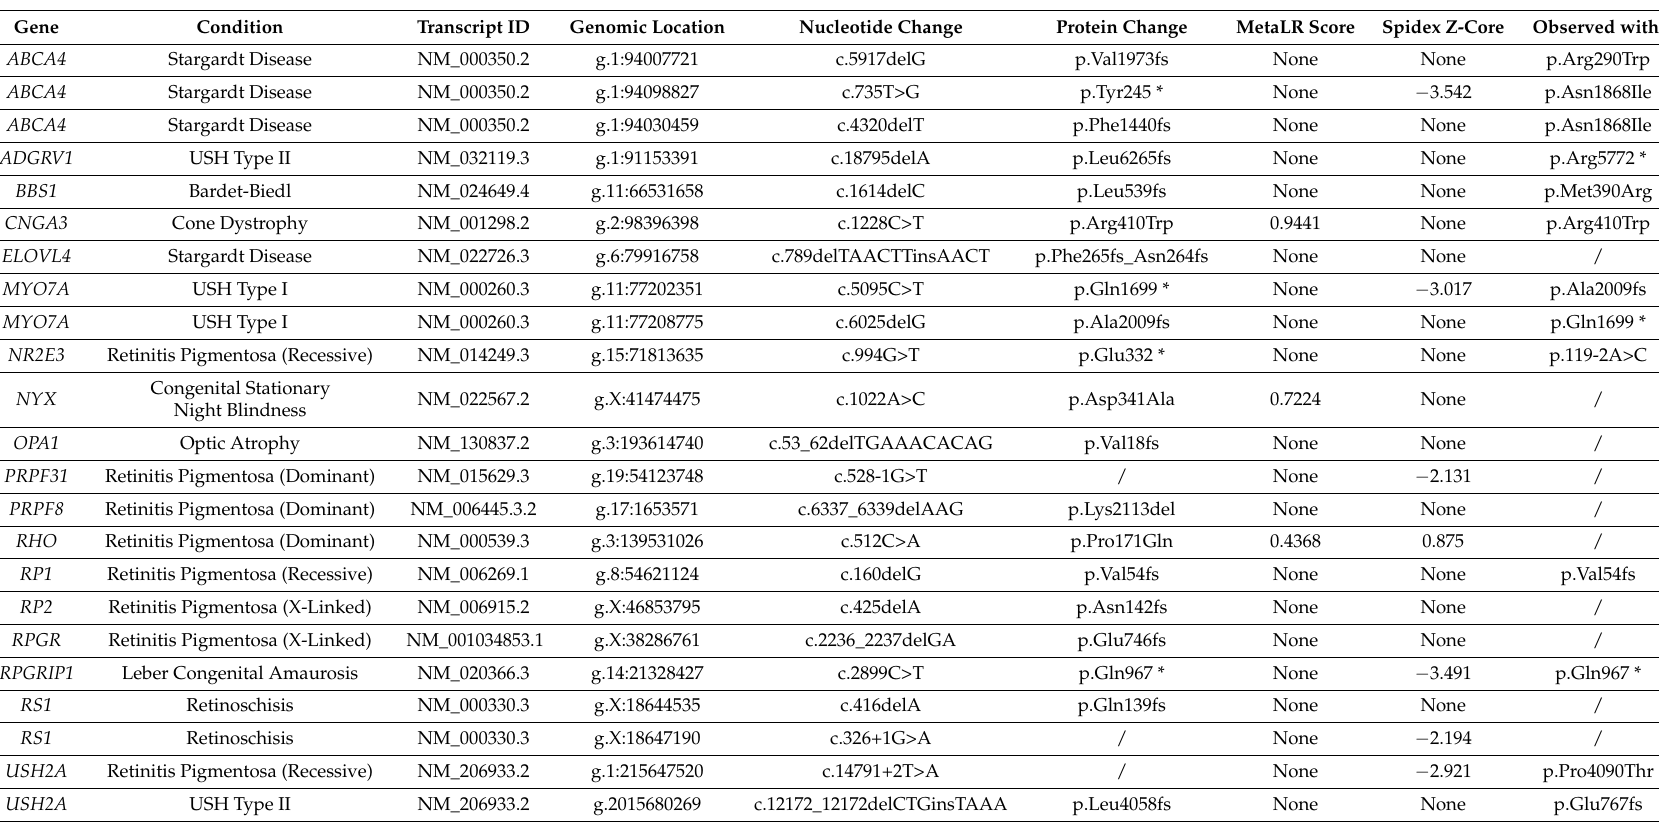
Table 1. Table of Novel Likely Pathogenic Variants. Missense mutations had to show segregation in pedigrees of at least 3 members, two of whom had to be affected. This table does not include the novel large structural variants that are reported in previous sections. The mutations in this table have not been previously associated with IRDs to the best of our